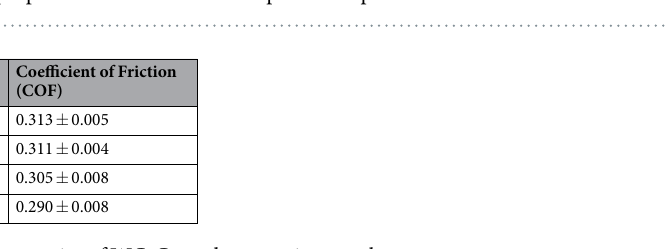
Table 3. Microscale tribological properties of WC-Co and composite